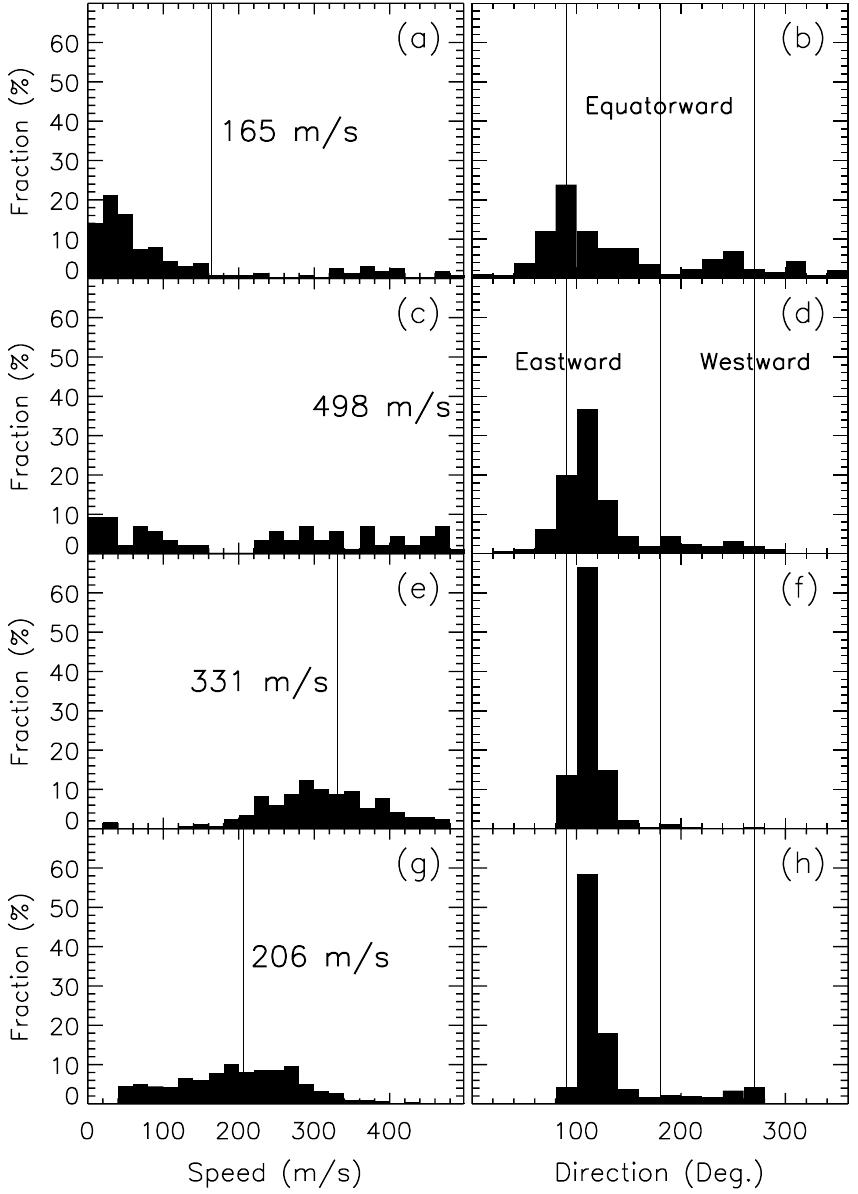
Fig. 2. (a) The change in the probability distributions of 2-D flow speeds (left column) and directions (right column) across the SWB during 12:15 to 15:00UT on 10 December 1999. The “fractions (%)” represent the fraction of the total number of samples for all vectors found (a) , (b) poleward of the SWB-3 ◦ , (c) , (d) in the poleward window SWB-3 ◦ to SWB-1 ◦ , (e) , (f) in the equatorward window SWB+2 ◦ to SWB+3 ◦ , and (g) , (h) equatorward of the SWB+3 ◦ (latitudes and SWBs are negative in the Southern Hemisphere). Average flow speeds are superimposed in the left column. Bin sizes of 20ms − 1 in flow speed and 20 ◦ in flow direction were used. A flow direction of 0 ◦ is poleward, 90 ◦ eastward, and 180 ◦ equatorward in magnetic